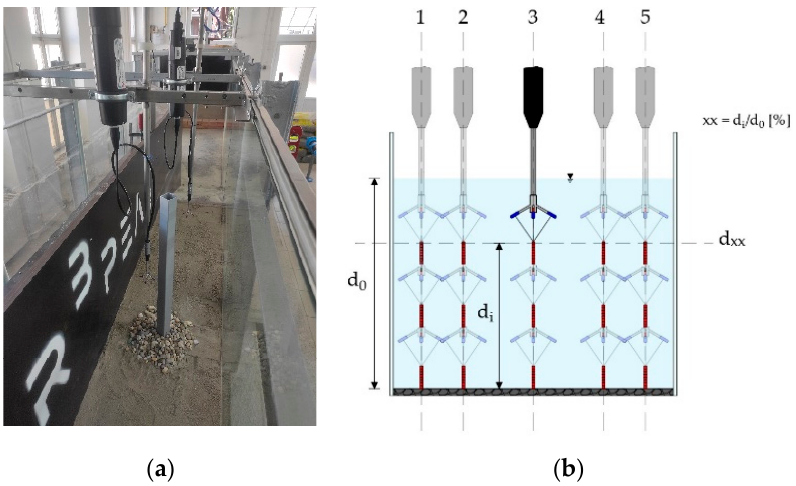
Figure 3. Photo of the physical model working section and ADVP instruments mounted on a rail cart ( a ), and scheme of the raster of the measurement points for a single experimental cross-section ( b ).